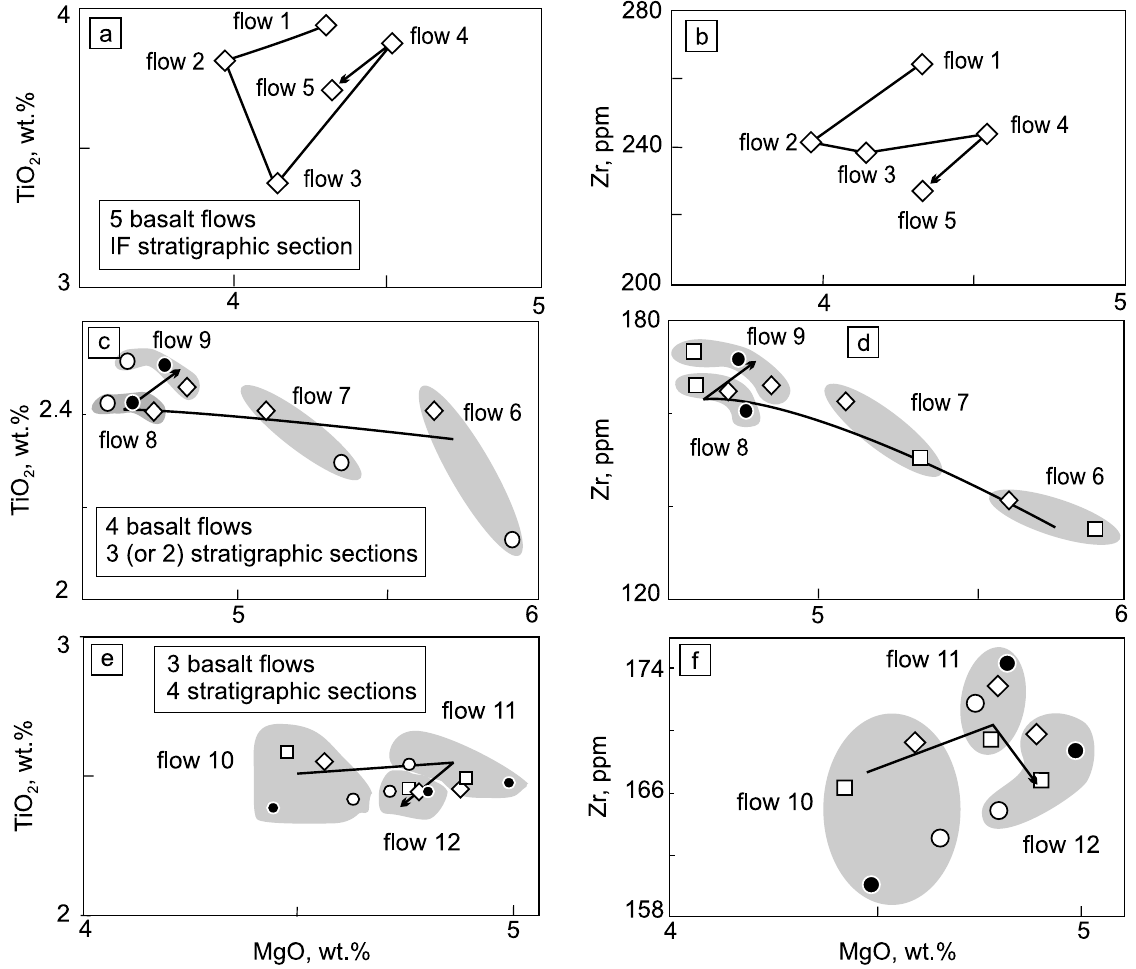
Fig. 8 – Variation diagrams of MgO versus TiO 2 and Zr showing the correlation of flows 1–5 (a, b) in the IF (Iraí-Frederico Westphalen) section; flows 6–9 (c, d), with flows 6 and 7 in IF and SP (São Paulo) sections, while flows 8–9 include the VA (Vista Alegre) section; flows 10–12 are present in all four studied sections. Arrows indicate the stratigraphic sense of chemical variation of basalt flows. Symbols of stratigraphic sections are the same as Figure 6.